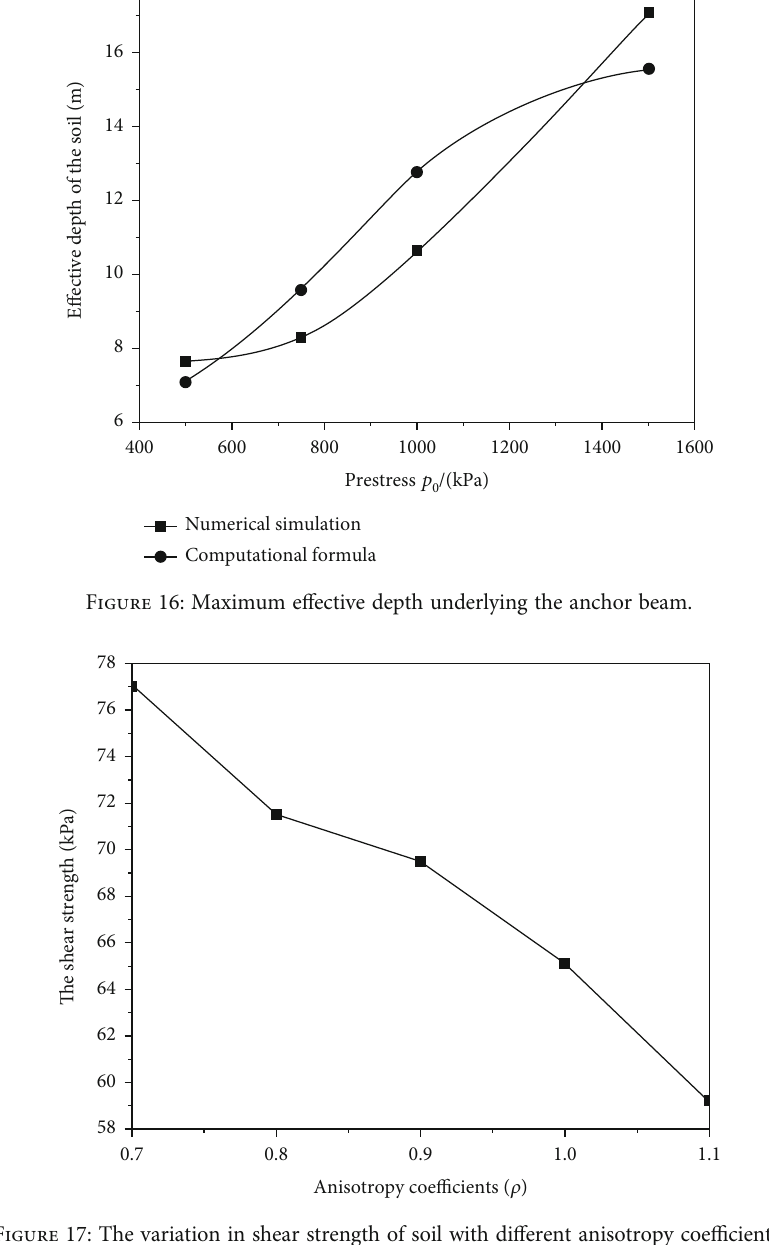
Figure 17: The variation in shear strength of soil with di ff erent anisotropy coe ffi